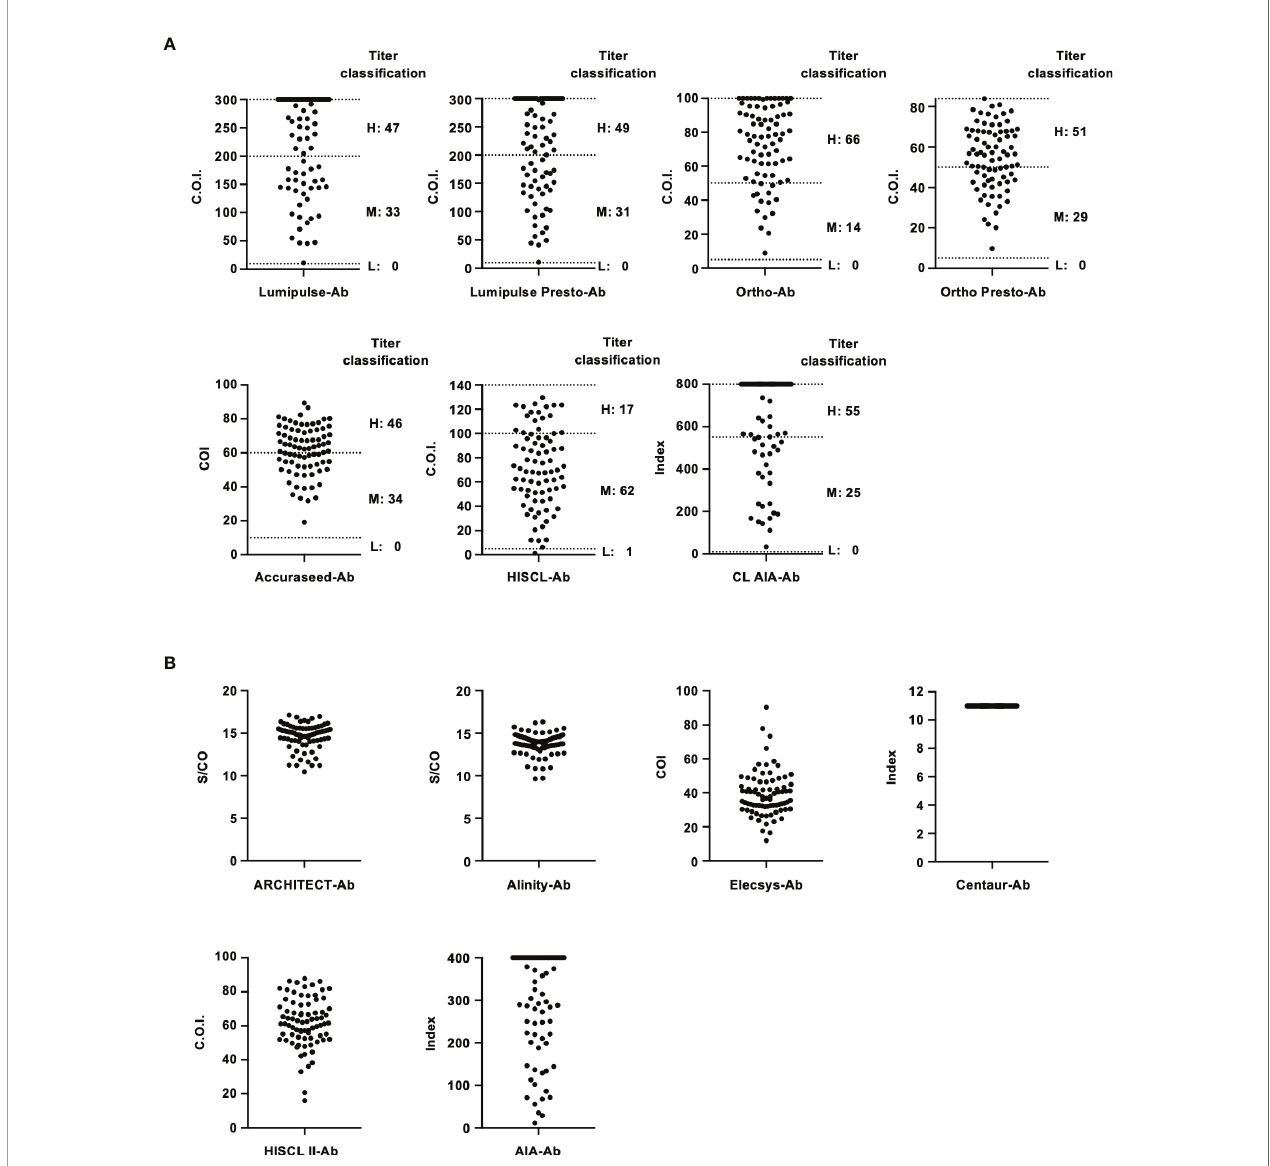
FIGURE 1 | Evaluation of HCV-positive specimens in the regional reference panel by anti-HCV detection kits. (A) Scatter dot plot of quanti fi ed values by 7 anti-HCV detection kits with titer classi fi cation. The numbers of specimens classi fi ed as high (H), middle (M), and low (L) titers are shown on the right of each plot. Dotted lines indicate the upper detection limit and boundaries between H and M and between M and L. (B) Scatter dot plot of quanti fi ed values by 6 anti-HCV detection kits without titer classi fi